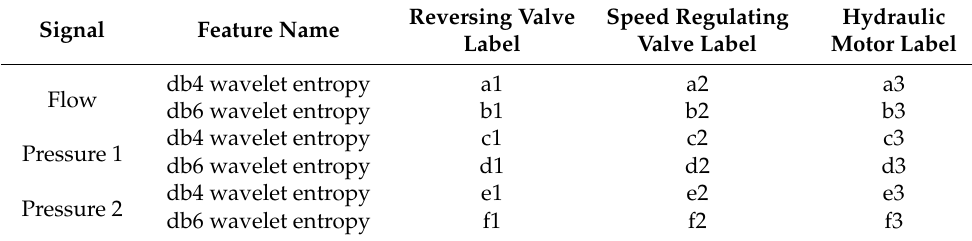
Table 7. Signal fault feature.